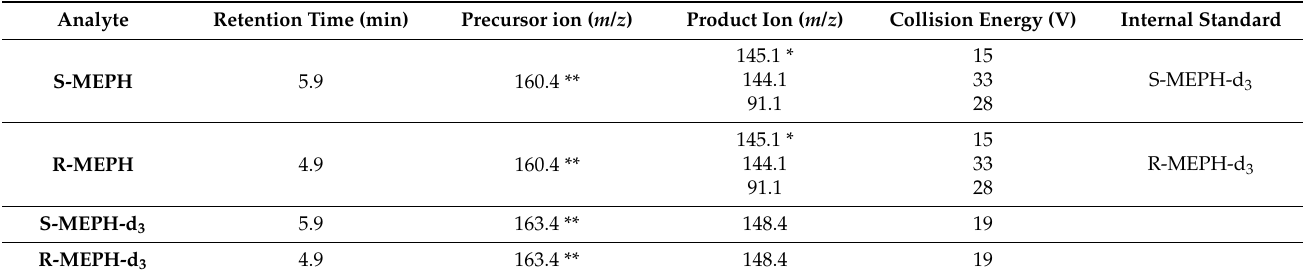
rate was 0.1 mL/min with 0.1% DEA in EtOH:MeOH (20:80 v / v ) as mobile phase used in an isocratic mode. The total run time was 10 min. Table 2. The retention time, selected reaction monitoring (SRM) transitions and collision energy for S-MEPH and R-MEPH. Analyte Retention Time (min) Precursor ion ( m / z ) Product Ion ( m / z ) Collision Energy (V) Internal Standard S-MEPH 5.9